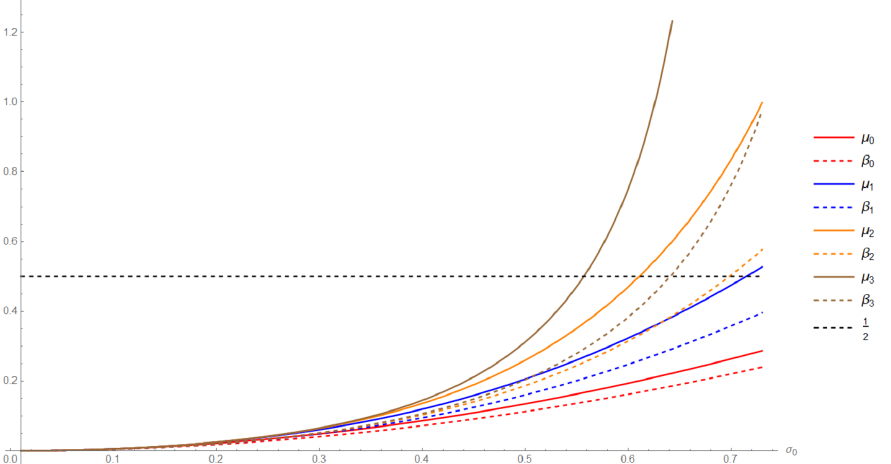
Figure 1. Comparison between the iterations µ i and β i for i = 0,1,2,3.